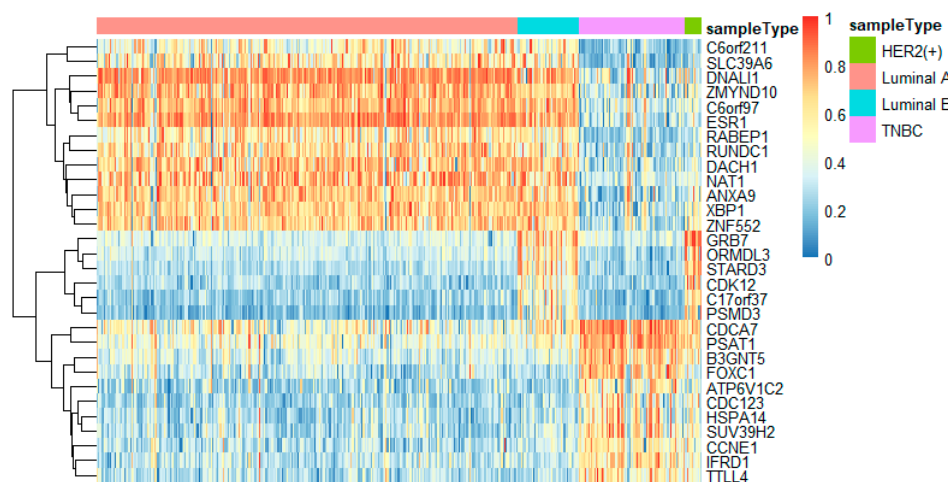
Figure 10. The heatmap of breast cancer subtypes on mRNA data.